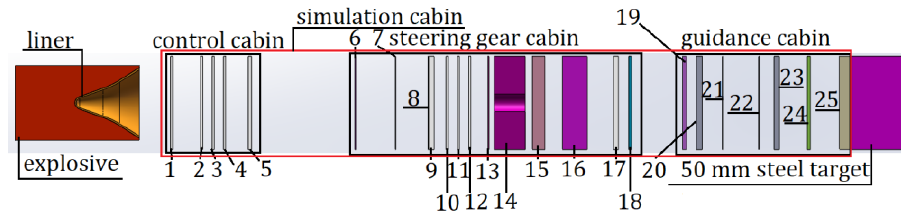
Figure 4. Penetration model with the simulation cabin.